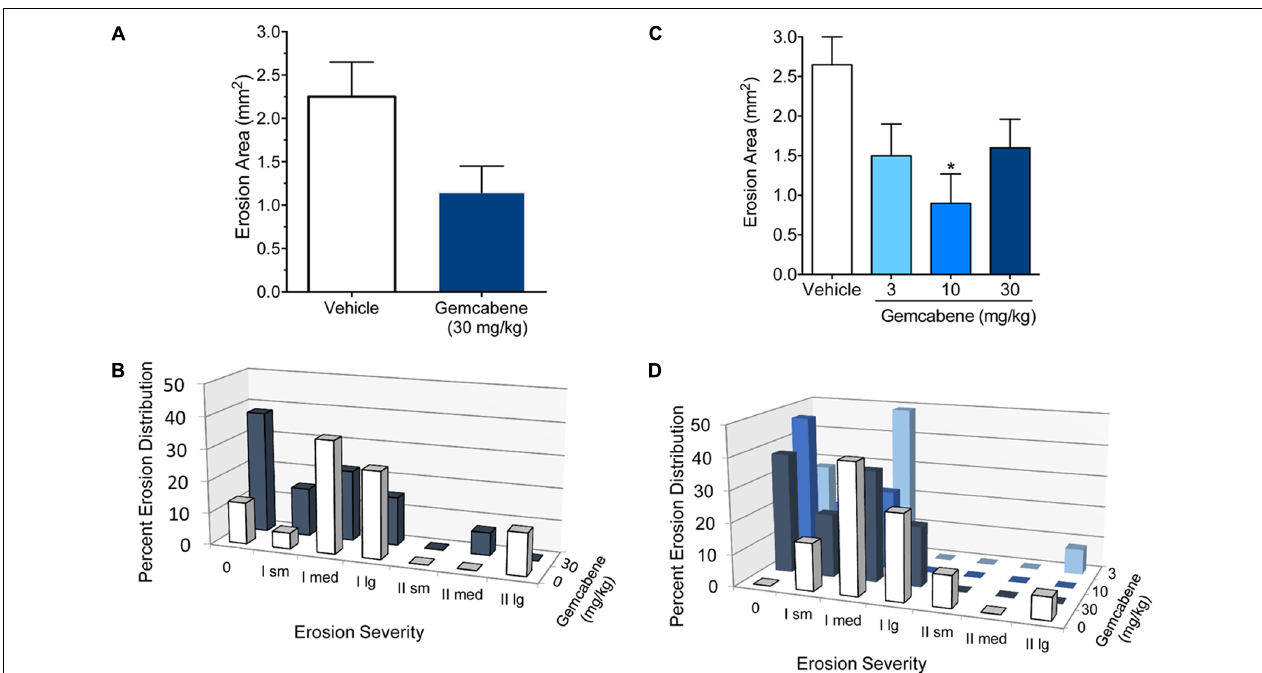
FIGURE 6 | Effect of emcabene on medial tibial plateau erosion area in the rat MIA model of OA. (A) MIA and saline were injected on day 0. Gemcabene (30 mg/kg) was given p.o., 0.5 h before MIA injection and was then given b.i.d for 28 days. Erosion analysis was performed on day 28. There were no statistically significant differences as determined by t -test ( p = 0.179). N = 12 rats per group. (B) Effect of Gemcabene (3, 10, and 30 mg/kg) on medial tibial plateau erosion area in the rat MIA model of OA. MIA and saline were injected on day 0. Gemcabene (3, 10, or 30 mg/kg) was given p.o., 0.5 h before MIA injection and was then given b.i.d for 28 days. Erosion analysis was performed on day 28. Only the 10 mg/kg group was statistically significant as determined by one-way ANOVA, Dunnett’s multiple comparisons procedure ( p < 0.05). N = 12 rats per group. (C) Percent erosion distribution from experiment in (A) with 30 mg/kg/d dose. (D) Percent erosion distribution from experiment in (B) with dose-response (10, 30, and 100 mg/kg). Data are expressed as Mean ± SEM.